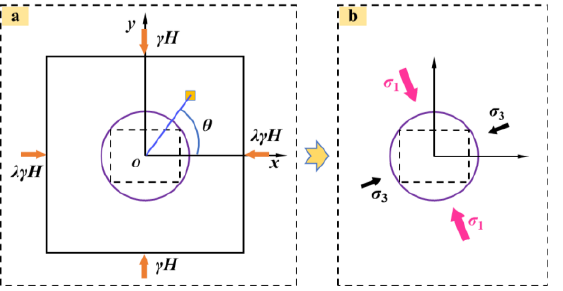
Figure 6. Expression of the principal stresses for the stress components. ( a ) Arbitrary stress field, ( b ) The direction deflection of the principal stress field and the partial-stress boosting.